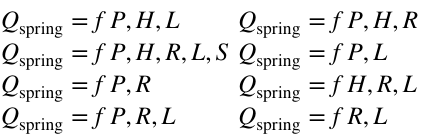
Also, the correlation between alluvial springs discharge and water table depth is − 0.23 (Sig. <